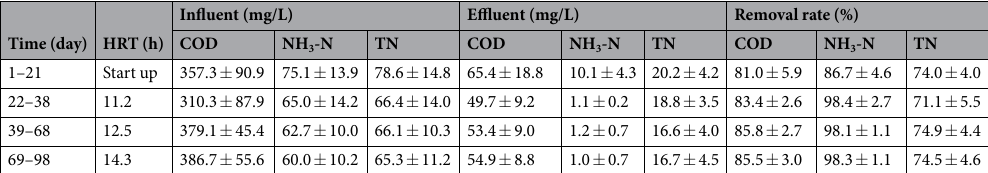
Table 1. System performance at different HRTs. Note: the concentrations in influent, effluent and the removal rate were calculated as the average values during the whole